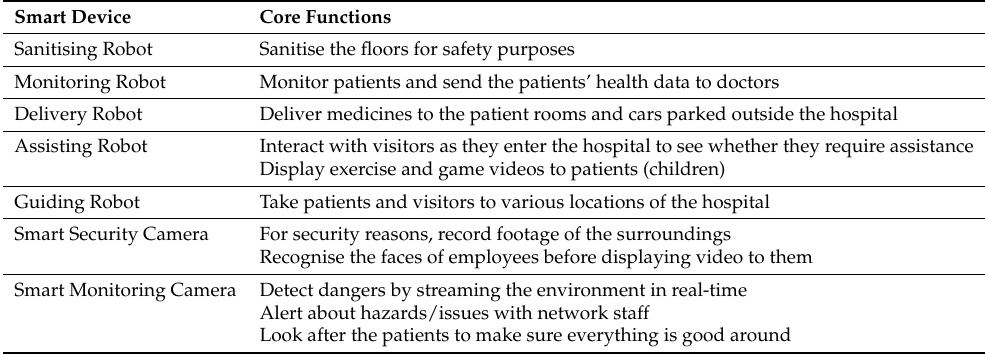
Table 4. Core functions of smart devices in children’s hospital